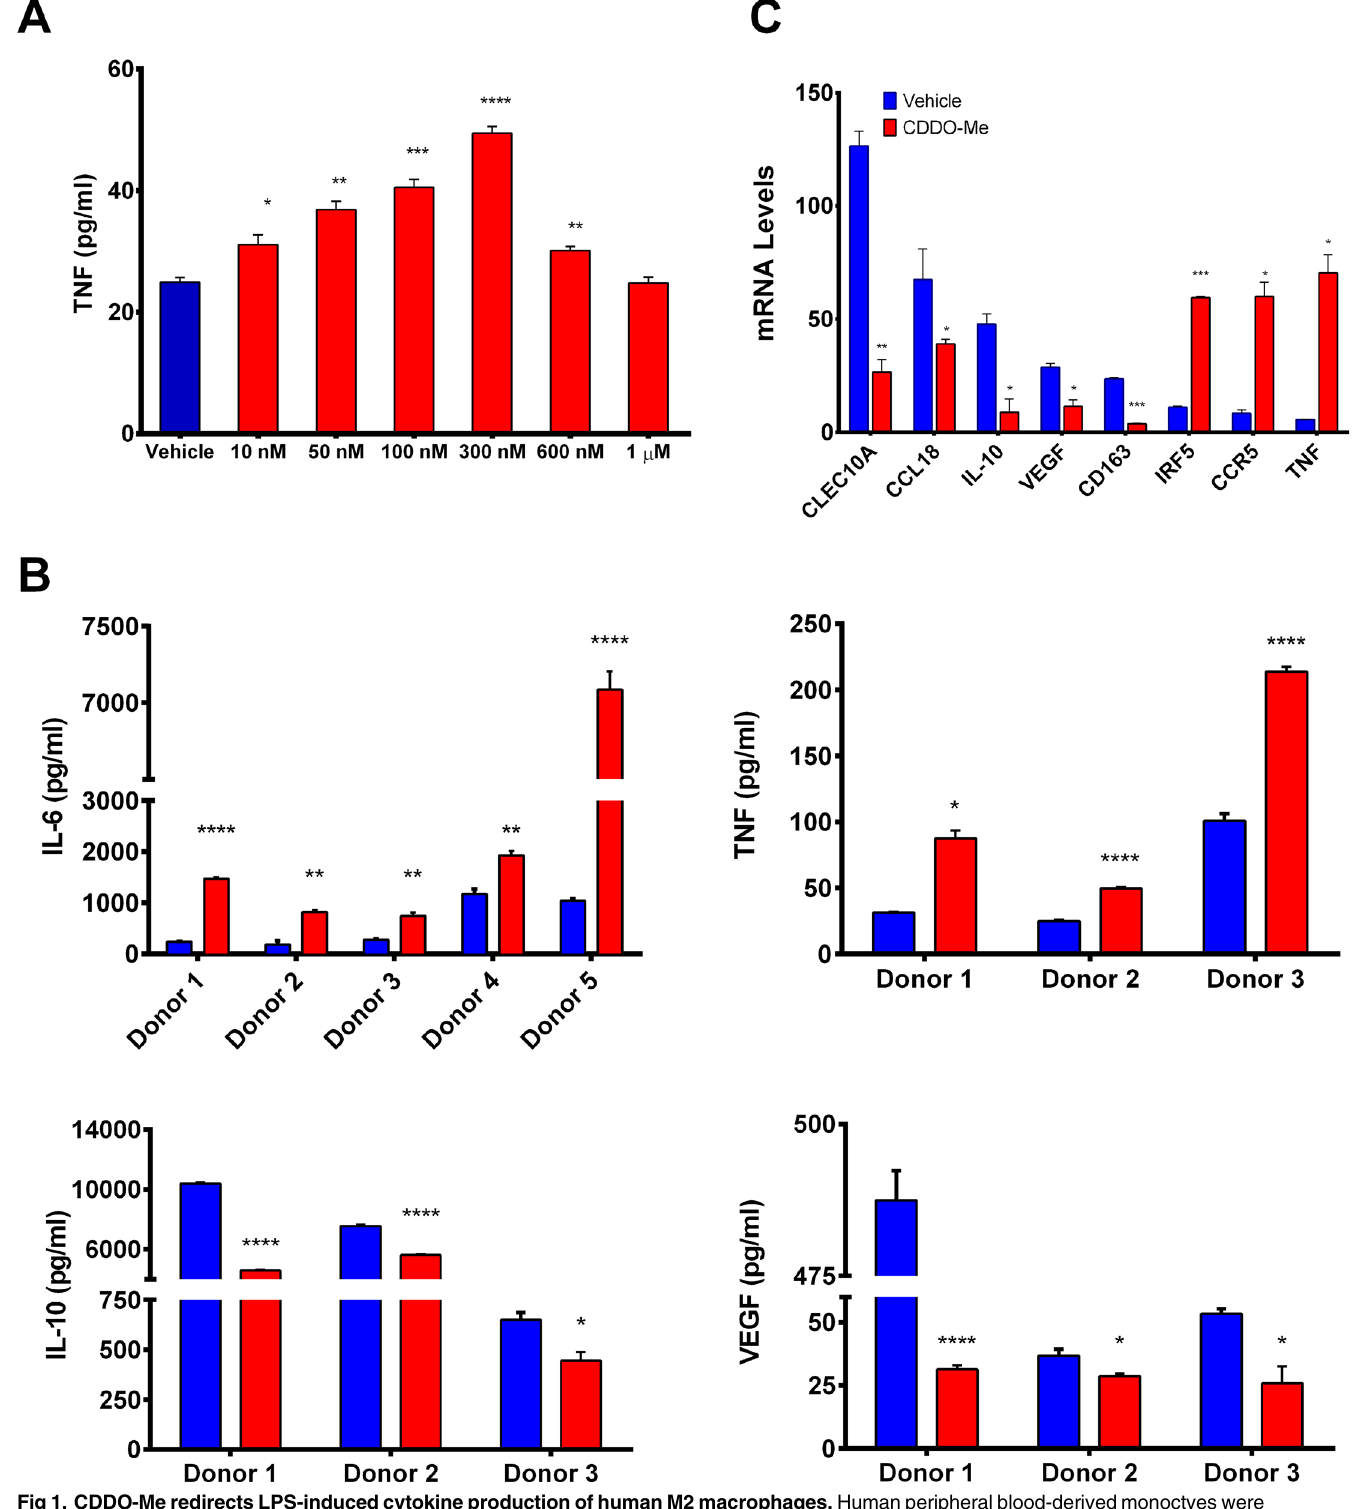
Fig 1. CDDO-Me redirects LPS-induced cytokine production of human M2 macrophages. Human peripheral blood-derived monoctyes were differentiated with M-CSF to generate alternatively activated (M2-polarized) macrophages. (A) CDDO-Me dose-dependently induced TNF- α secretion in LPS-stimulated macrophages. Culture supernatants from macrophages treated with CDDO-Me or DMSO control for 16 hrs prior to stimulation with LPS (10